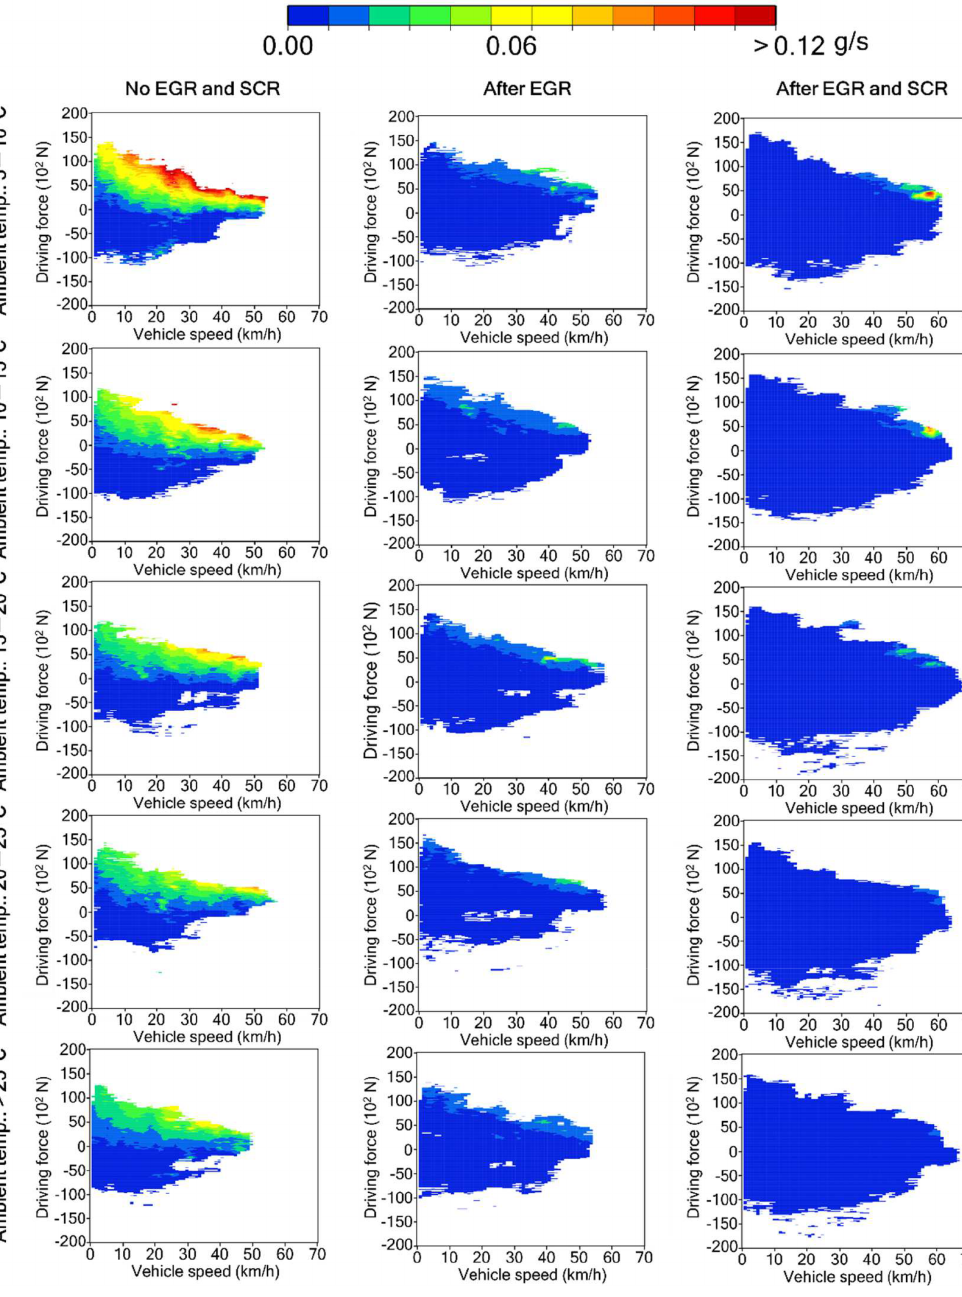
Figure 4. Transient emission map for NO x emissions evaluated using a real-world driving emission test conducted using PEMS, as well as the vehicle driving force and speed